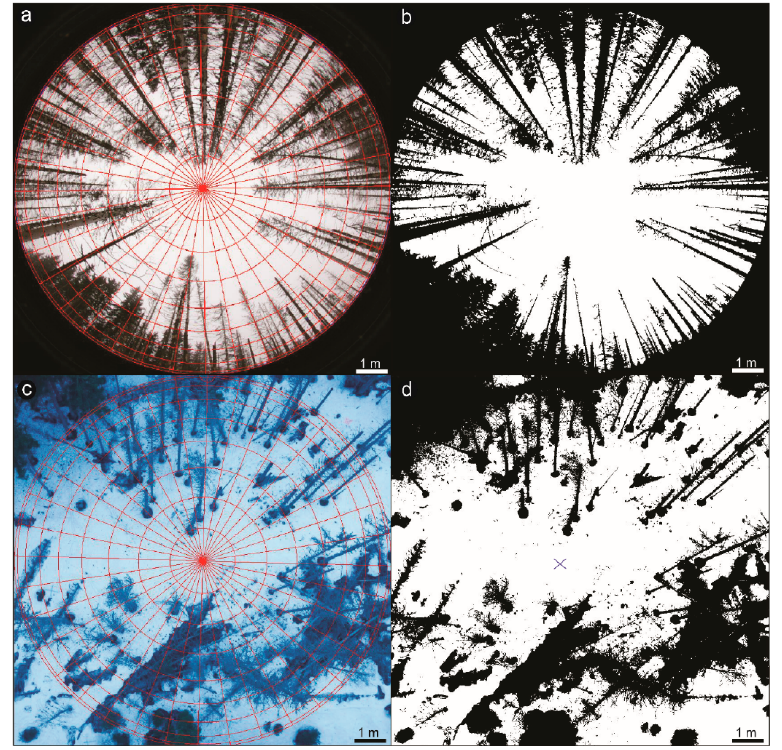
Figure 4. Illustration of Gap Light Analyzer (GLA) environment for a fisheye lens. ( a ) Registration of image—setting the reference of north orientation and setting the 180° range; ( b ) Settings of the threshold value—the hardness of determination which pixels would be computed like “clear sky” and which would be computed as “view obstacles”; ( c ) Illustration of GLA environment for rectangle lens with orthographic projection settings. Registration of image remains the same like for the fisheye lens, as well the thresholding of the image in the LAI ground measurement plot of ( d ) showing the blue cross sign as seen from the UAV downward-looking images. The UAV surveys for LAI retrieval were performed in partly sunny to overcast conditions. Overcast conditions are more preferable to avoid shadows on the forest floor [60], which can hamper exact LAI retrieval, but images could be analyzed with adequate accuracy. The UAV-based LAI eff values were estimated from measurements that were taken at two different altitudes (at ~50 m and ~65 m) to determine whether there were observed differences in the LAI eff retrieval between the optimal height and higher ones. The downward-looking UAV images were taken from nadir position